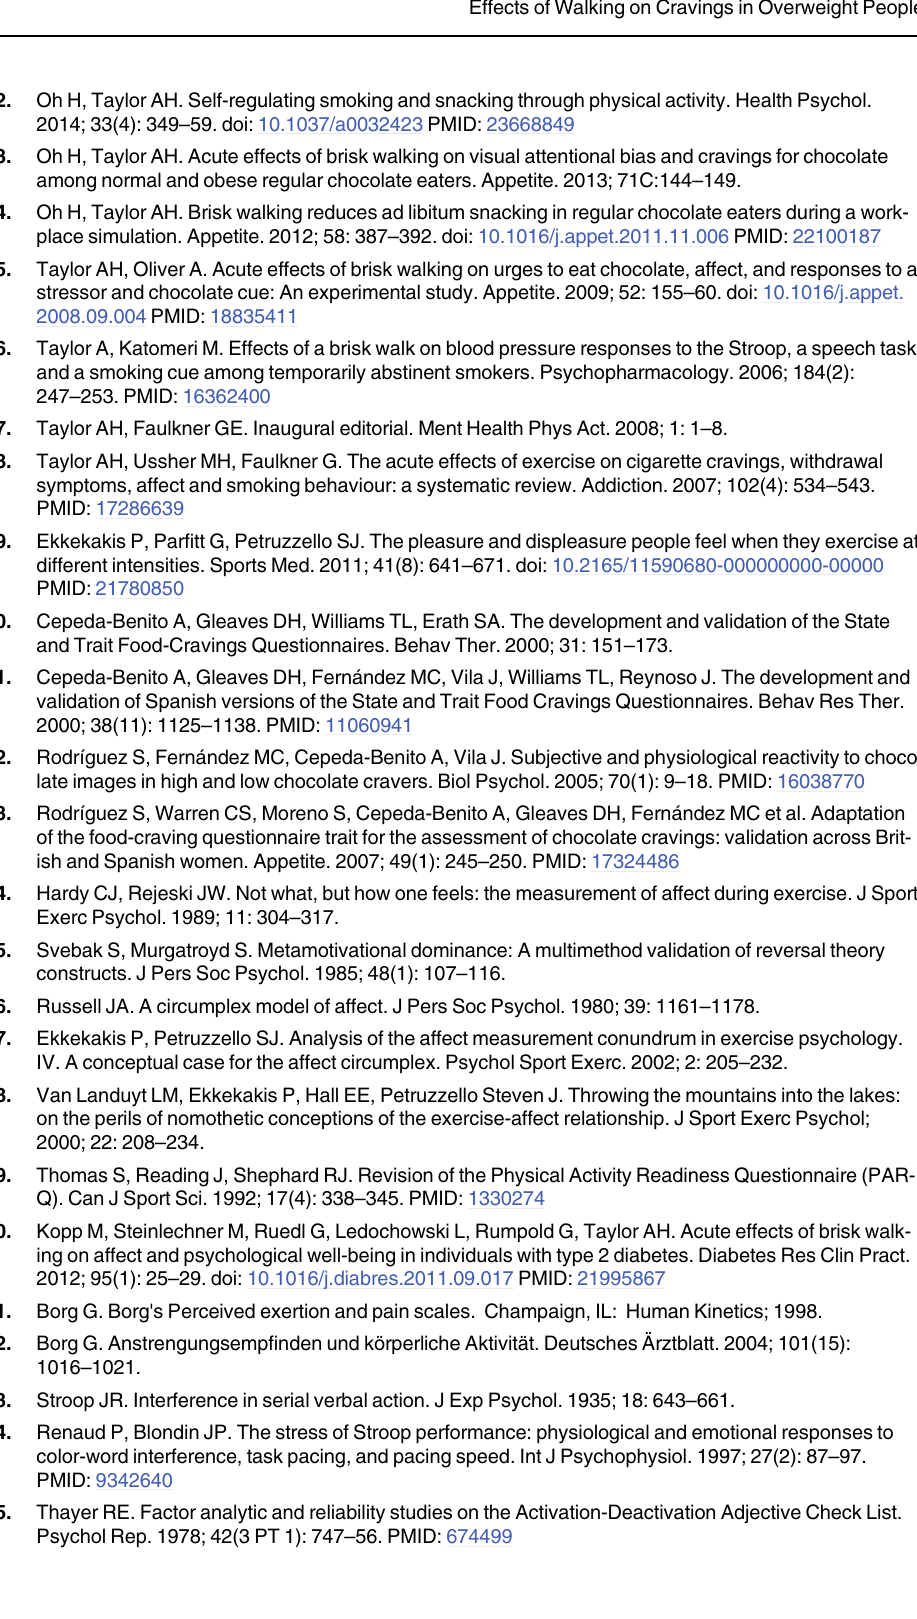
PLOS ONE | DOI:10.1371/journal.pone.0119278 March 11,